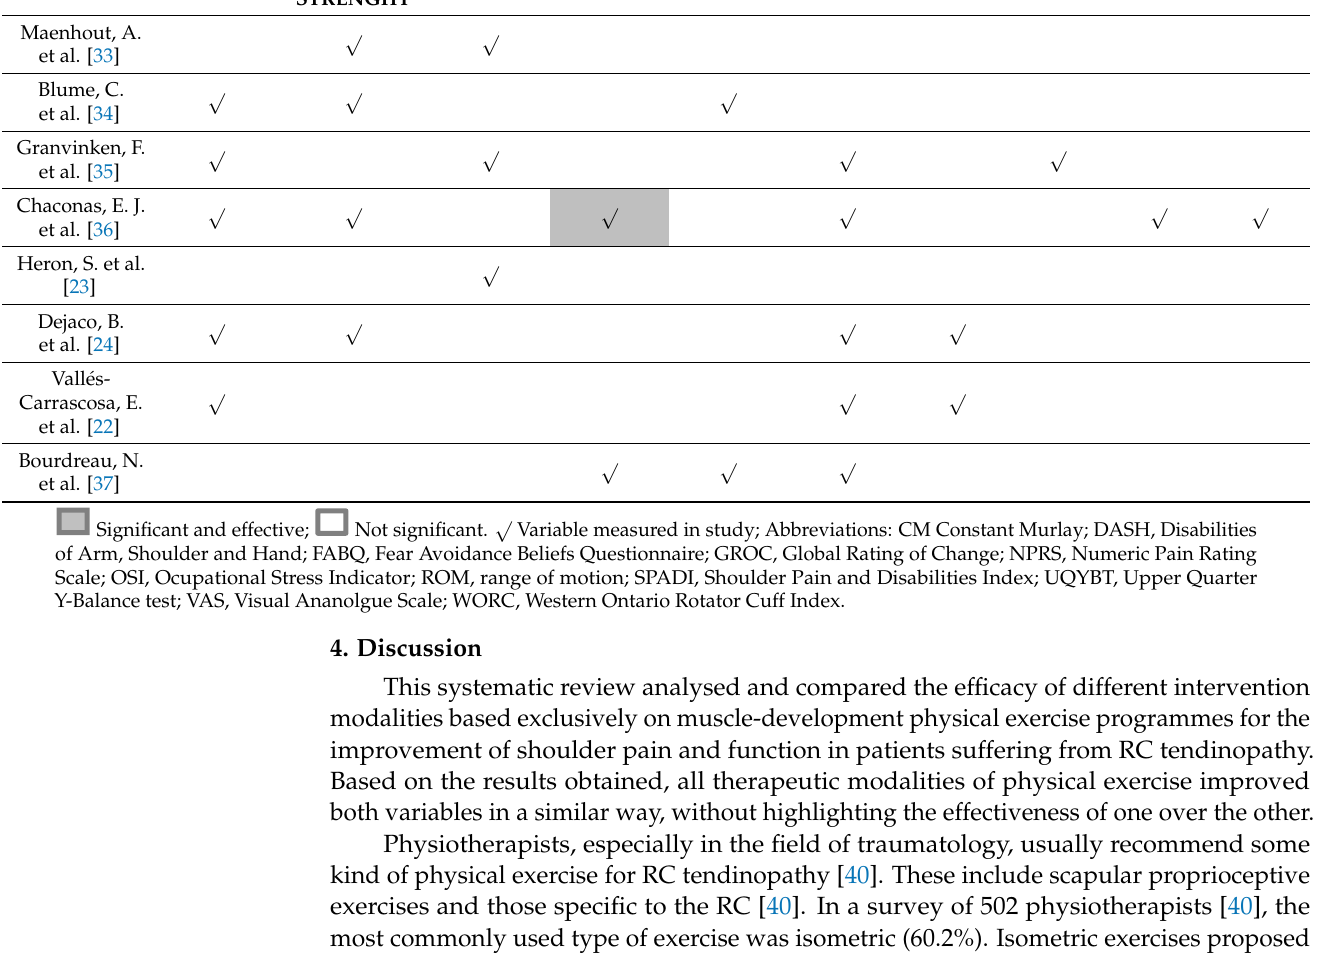
Table 7. Interventions based on muscle development with load and their effectiveness based on the variables studied. ISOMETRIC ROM STRENGHT